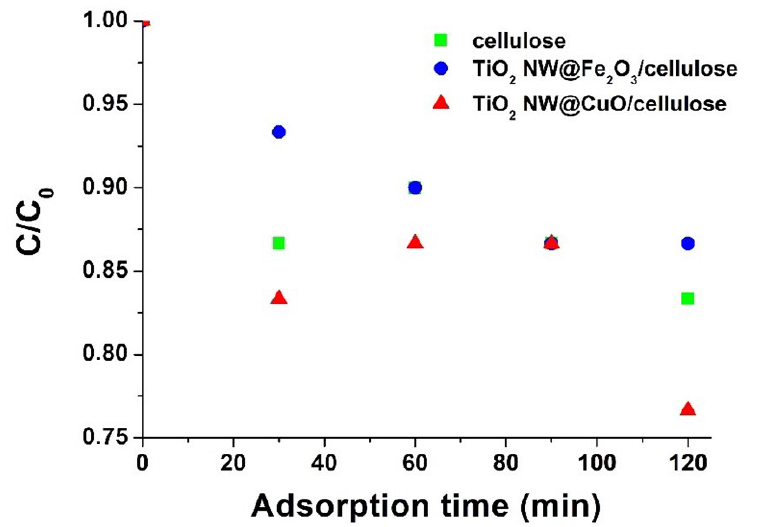
Figure 6. Adsorption capacity of pure cellulose (green marks) as well as TiO 2 NW@Fe 2 O 3 /cellulose (blue marks) and TiO 2 NW@CuO/cellulose (red marks) hybrid membranes in MB adsorption